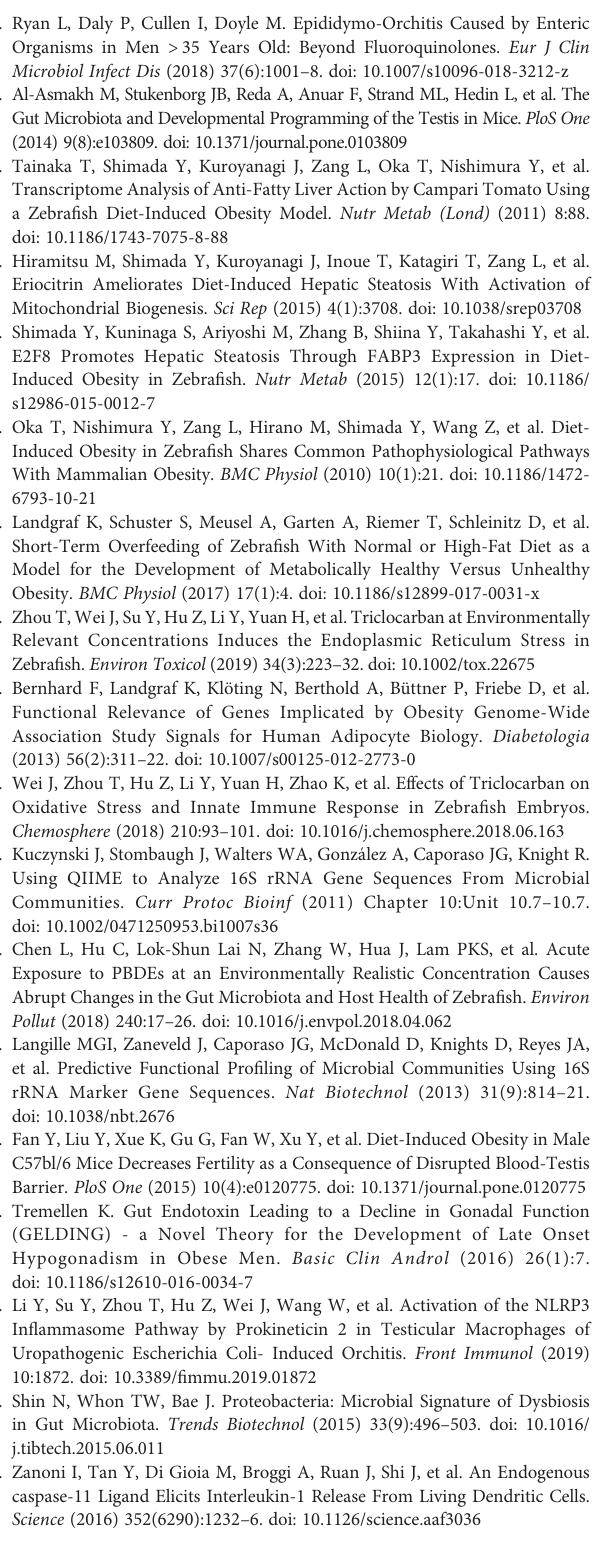
Supplementary Figure 5 | Venn plot population analysis results of all samples, including gut and testicular